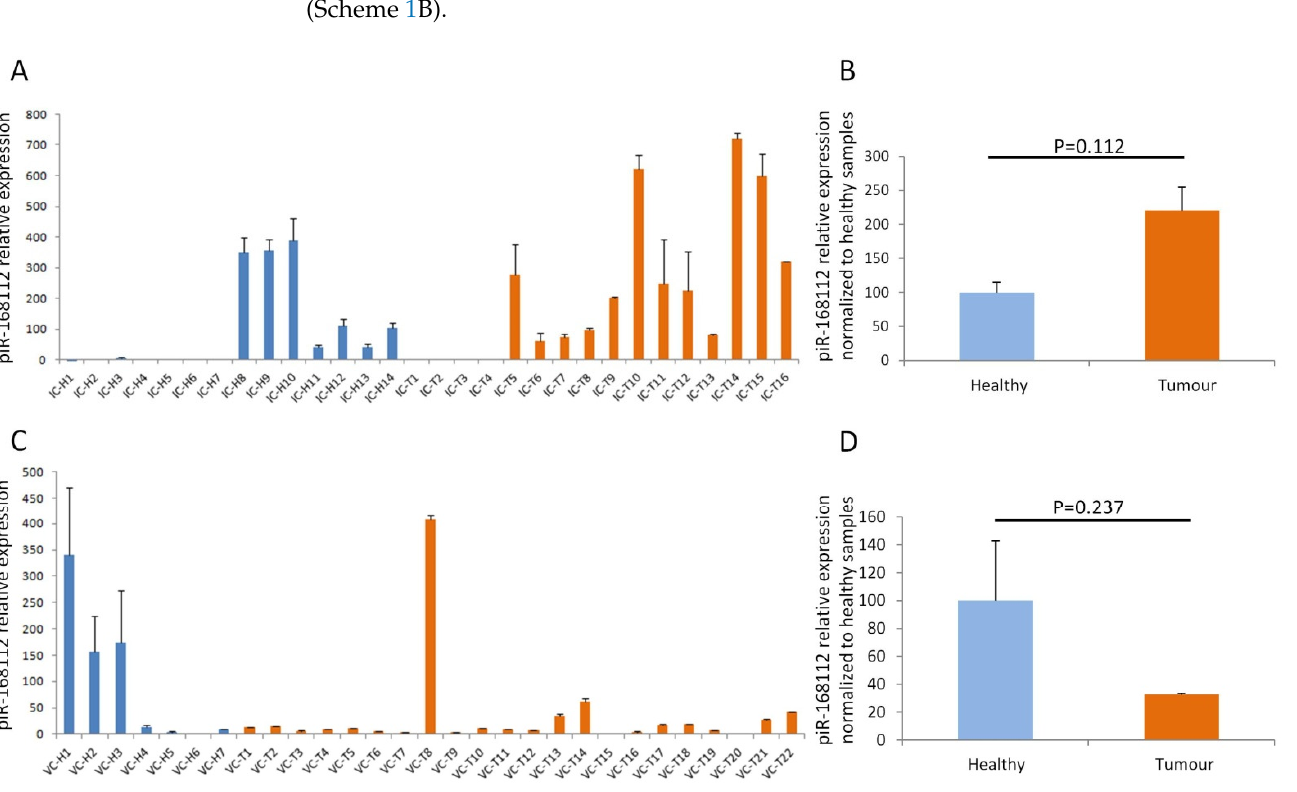
Scheme 1. Expression of piR-168112 in human plasma samples. ( A ) Relative piR-168112 expression in plasma samples from 14 healthy donors and 16 PDAC patients recruited institutionally. ( B ) Statistical analysis of piR-168112 expression in plasma samples from our institutional cohort grouped by their status, i.e., healthy or tumour. ( C ) Relative piR-168112 expression in plasma samples from seven healthy donors and 22 PDAC patients from a validation cohort. ( D ) Statistical analysis of piR-168112 expression in plasma samples from the validation cohort grouped by healthy or tumour status. IC-H: Institutional cohort healthy samples. IC-T: Institutional cohort tumour samples. VC-H: Validation cohort healthy samples. VC-T: Validation cohort tumour samples. p -values < 0.05 were considered statistically significant.